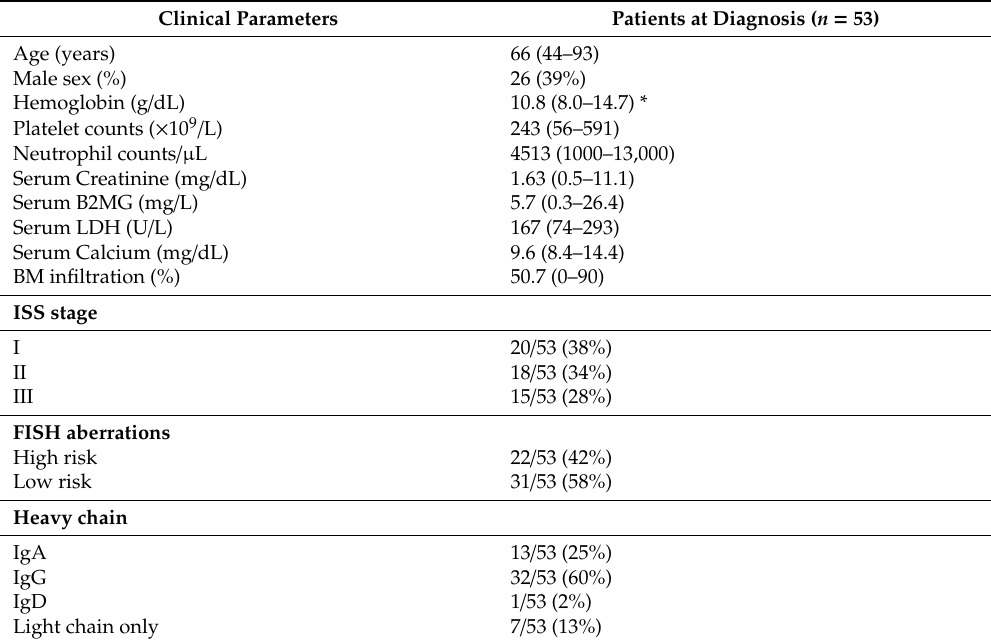
Table 1. Clinical characteristics of newly diagnosed Multiple Myeloma (MM) patients included in our